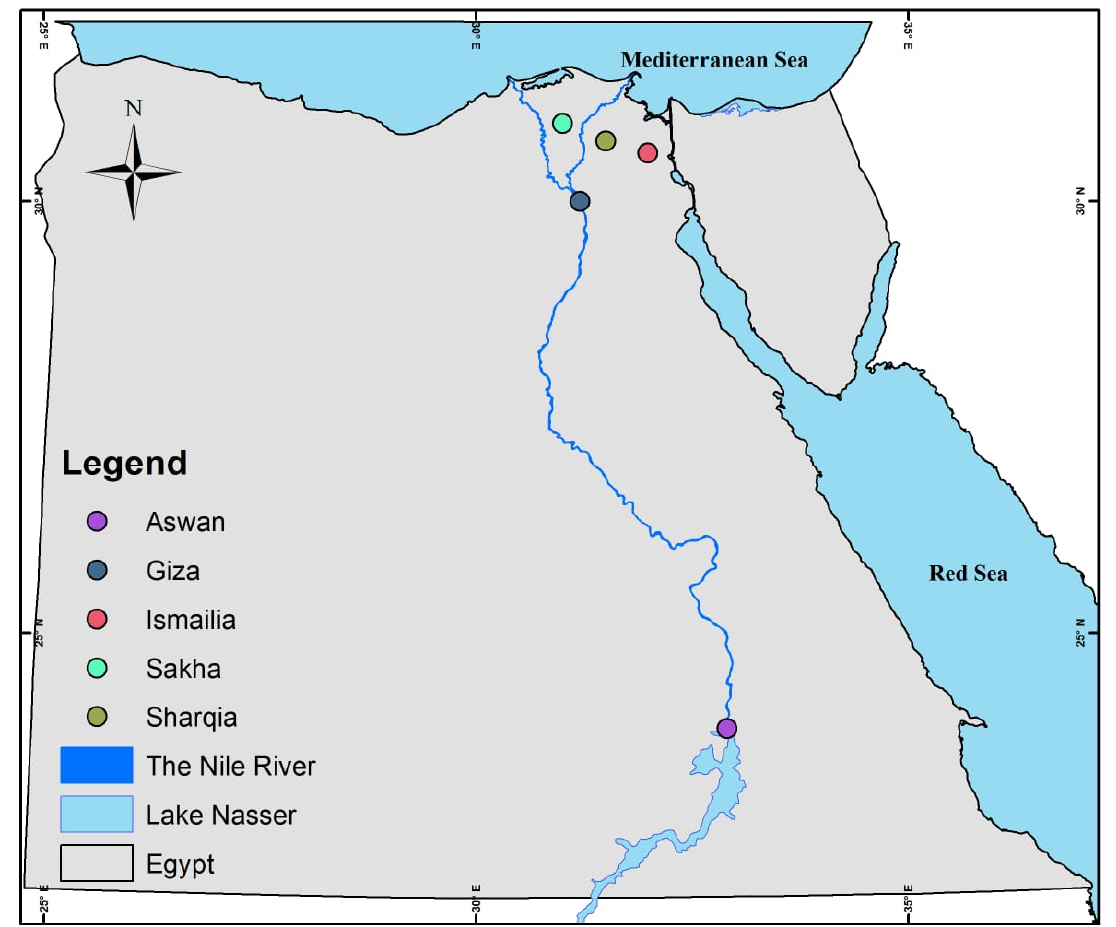
Figure 2. Locations of the field experiments used in DSSAT maize calibrations and evaluations. Eight-year site field experiments conducted on Ismailia used for CERES-Maize calibrations for phenology and grain yield of maize as well as soil moisture content and evapotranspiration. Experiments of other locations such as Sakha, Sharqia, Giza, and Aswan over three growing seasons were used to validate the model by comparing the observed phenology, leaf area index, grain yield, and biomass yield with analog-simulated values.